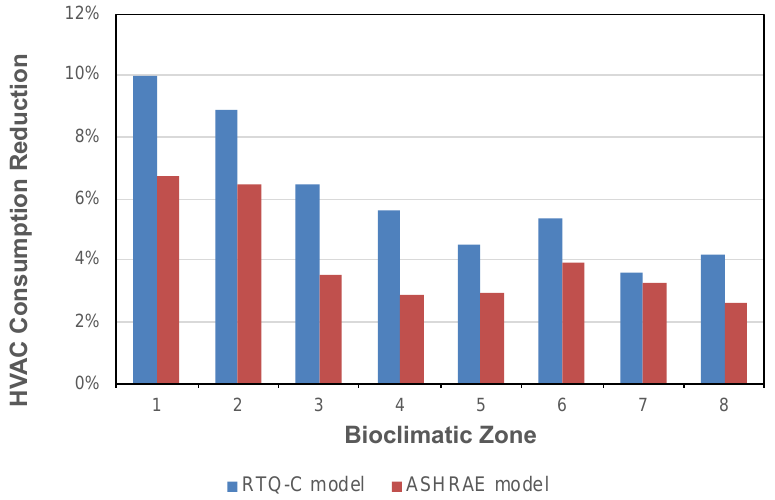
Figure 9. HVAC reduction for T ch /T as integrated optimisation control.